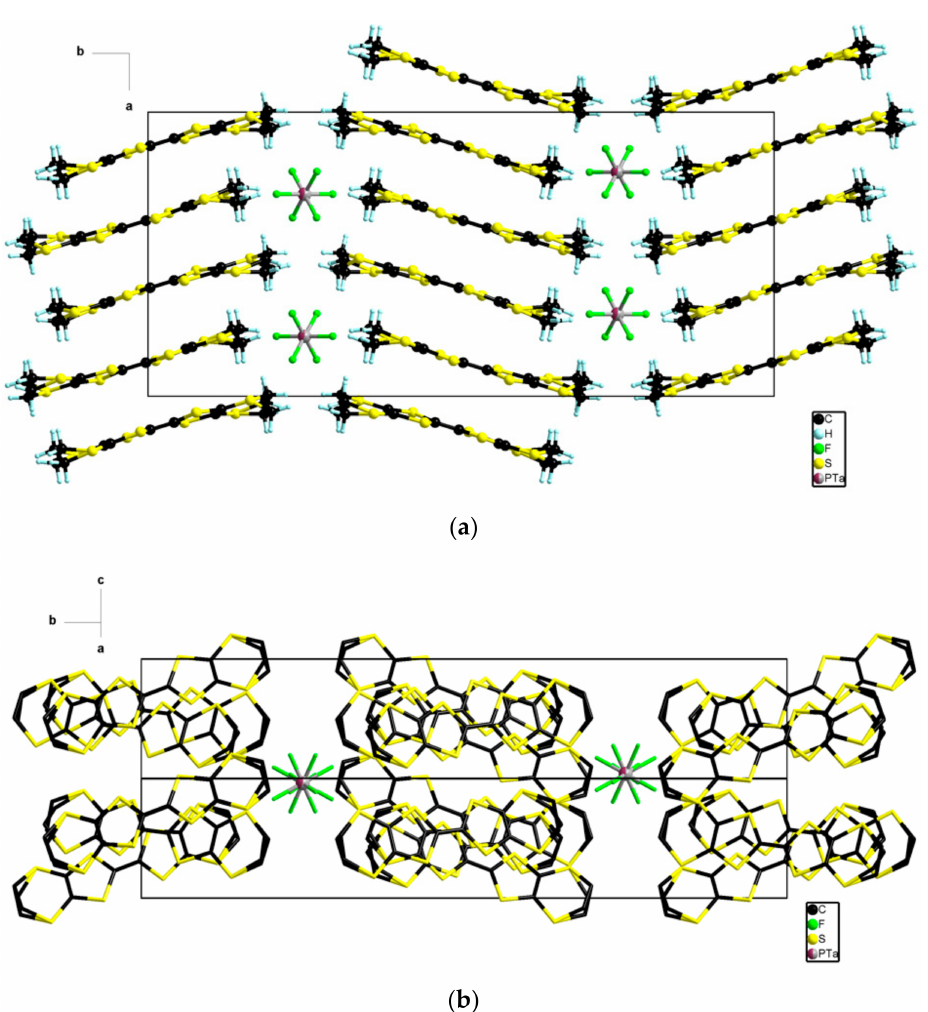
Figure 5. View of the packing in the ab plane ( a ) and in the bc plane ( b ) in the structure of δ o -(BEDT- TTF) 2 (TaF 6 ) 0.43 (PF 6 ) 0.57